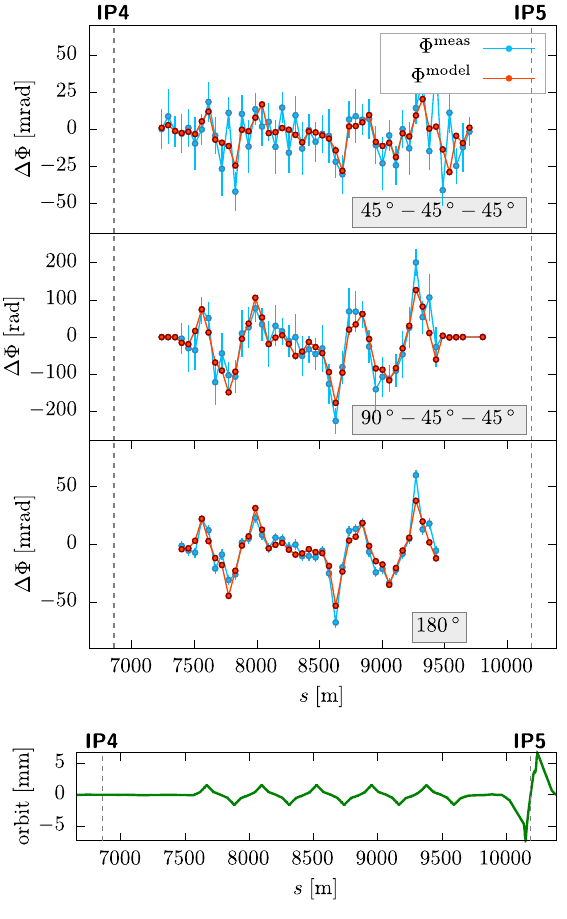
FIG. 9. The local observable with the error distribution of Table I and phase noise of 0 . 7 × 10 − 3 × 2 π rad. Additionally the orbit has been changed by dispersion bumps. The orbit offset creates feed-down from sextupoles.